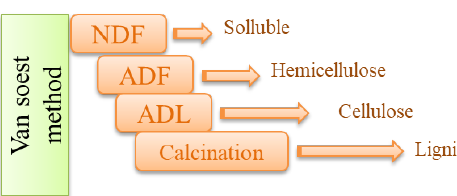
Figure 2. Schematic drawing of the Van Soest method for biomass decomposition